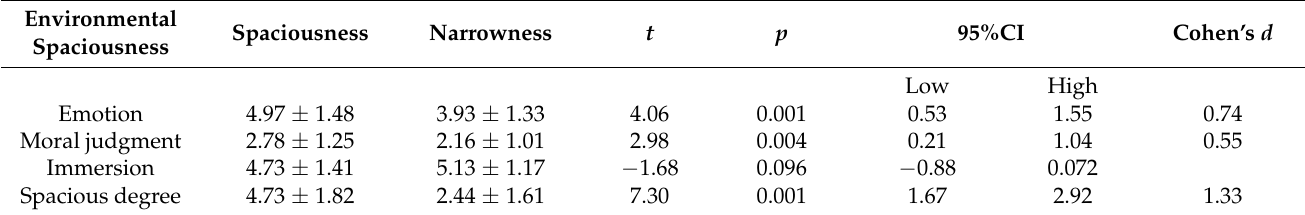
Table 2. The Mean rating score in different conditions.